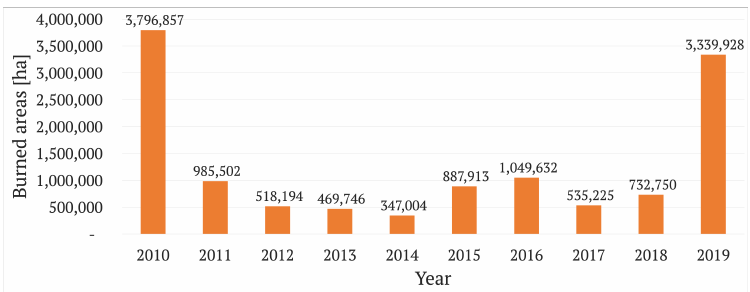
Figure 3. Burned areas in the department of Santa Cruz (Bolivia) from 2010 to